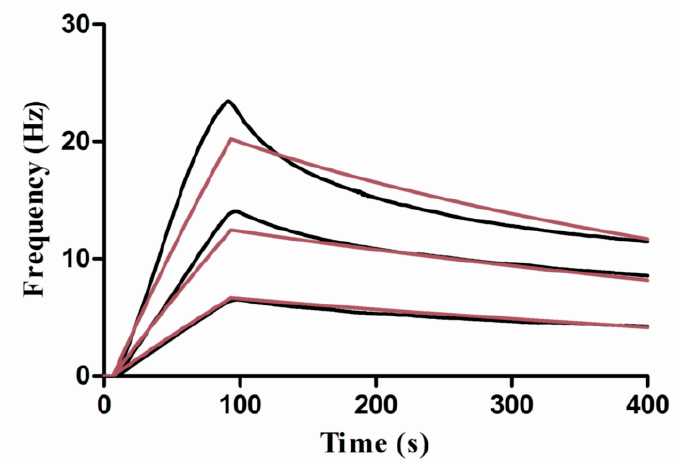
Figure 8. Kinetic evaluation of WGA and GlcNAc interaction. The WGA at 10, 5, 2 µ g/mL was injected